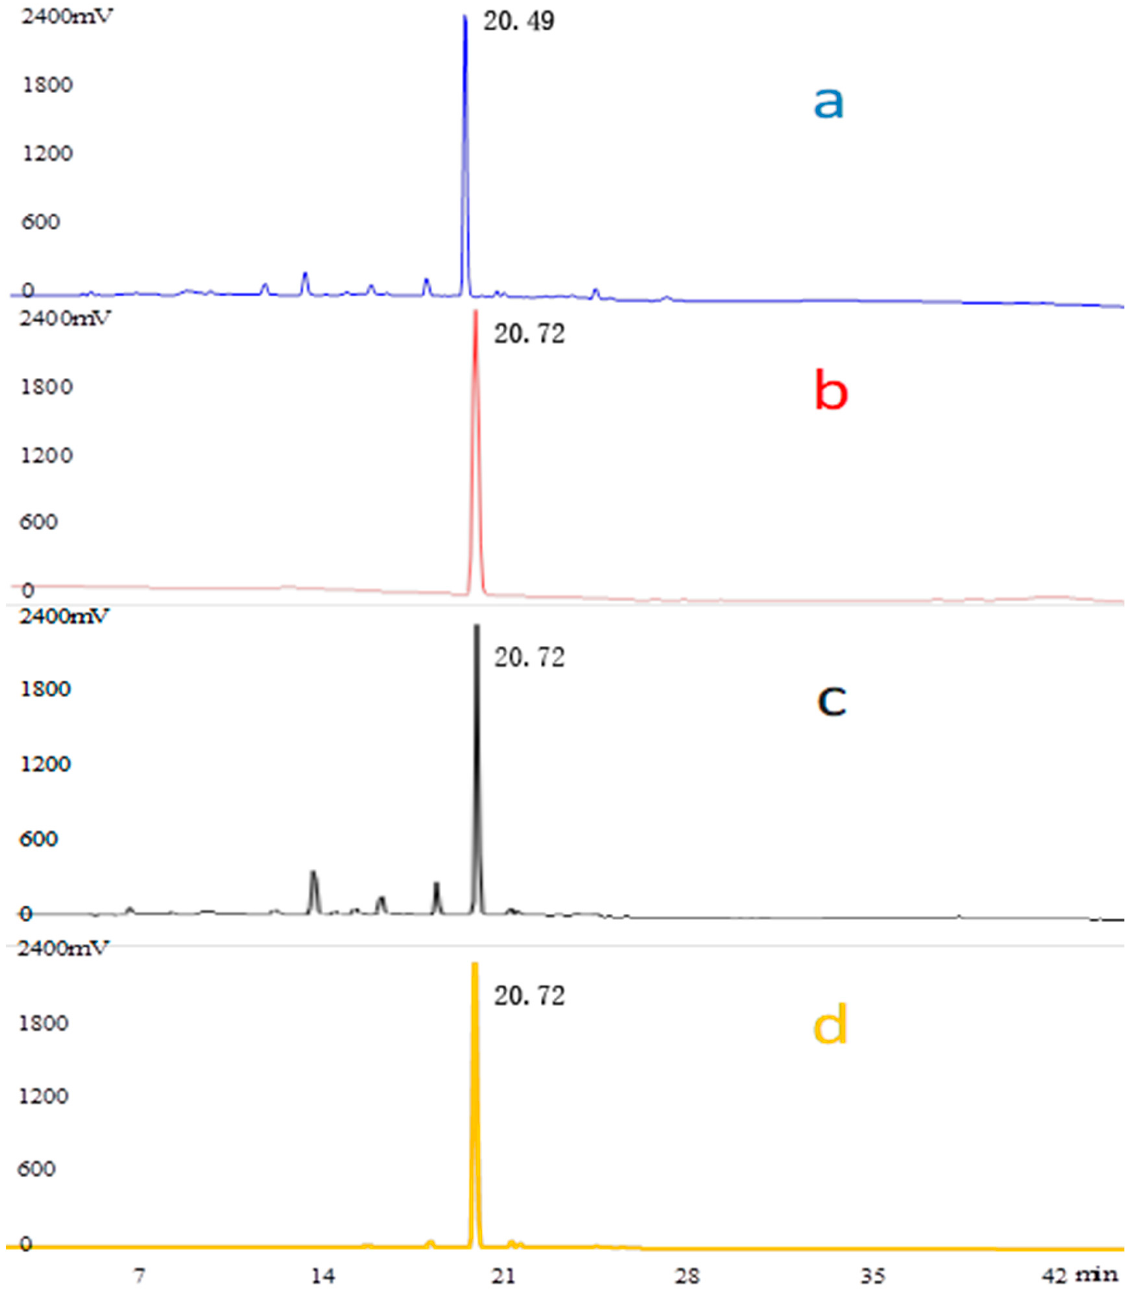
Figure 1. HPLC chromatograms. λ = 238 nm of the crude EGJ ( a ), the standard compound of geniposide ( b ), the 20% EGJ ( c ), and the No.4 sample ( d ). On the basis of the primary and secondary mass spectra of crocin I, the mass-to- charge ratio ( m / z ) of crocin I ([M+Na] + ) with sodium ions was 999.3741, crocin I ([M+H] + ) corresponded to 976.3801; crocin I with the sodium ions stripped of the disaccharides ([M- 2glc+Na] + ) was the fragment ion 675.2639, crocin I stripped of two disaccharides ([M-4glc] + ) was 329.1755, and one molecule of disaccharide with the sodium ions ([M-2glc-C 20 H 20 O 3 ] + ) was 347.0957, as shown in Figure 4B. It was presumed that it was relatively easy to break the glycosidic bond attached to the parent chain from the disaccharide at both ends of crocin I. Its mass spectral cleavage pathway is shown in Figure